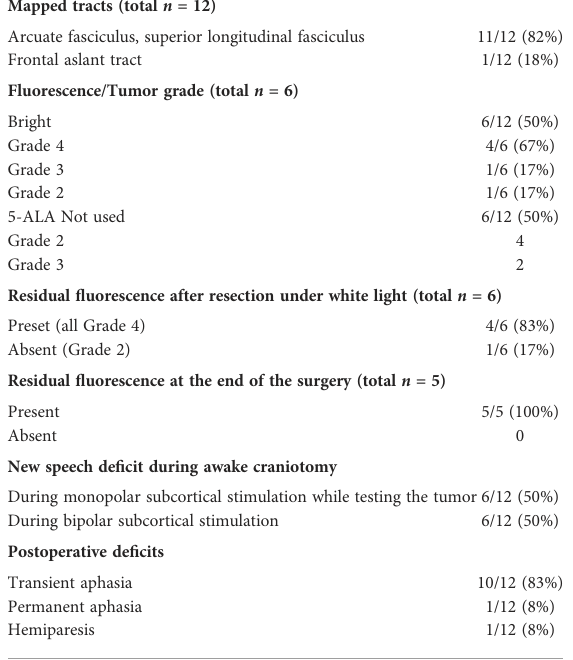
TABLE 2 Patients with cortical and subcortical mapping (after 2016), n = 12.